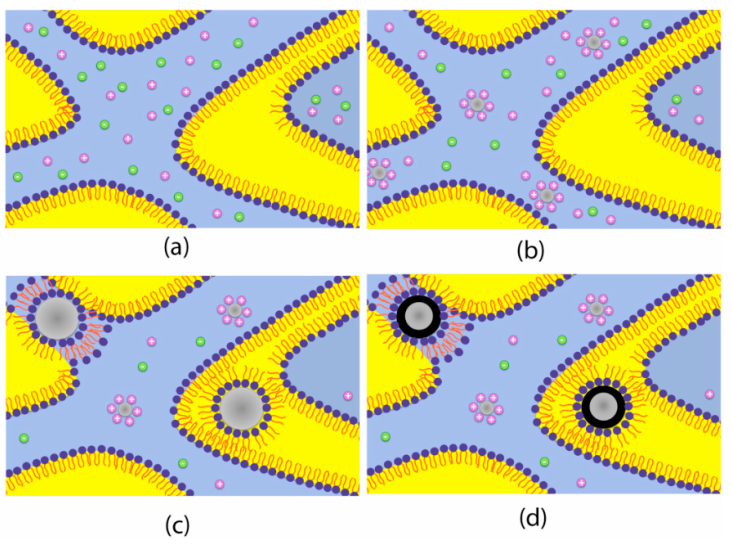
Figure 3. Schematic picture of core particle formation ( a )–( c ) and subsequent galvanic displacement to form final core-shell particles ( d ). Graphics adapted with permission from [26], 2014, American Chemical